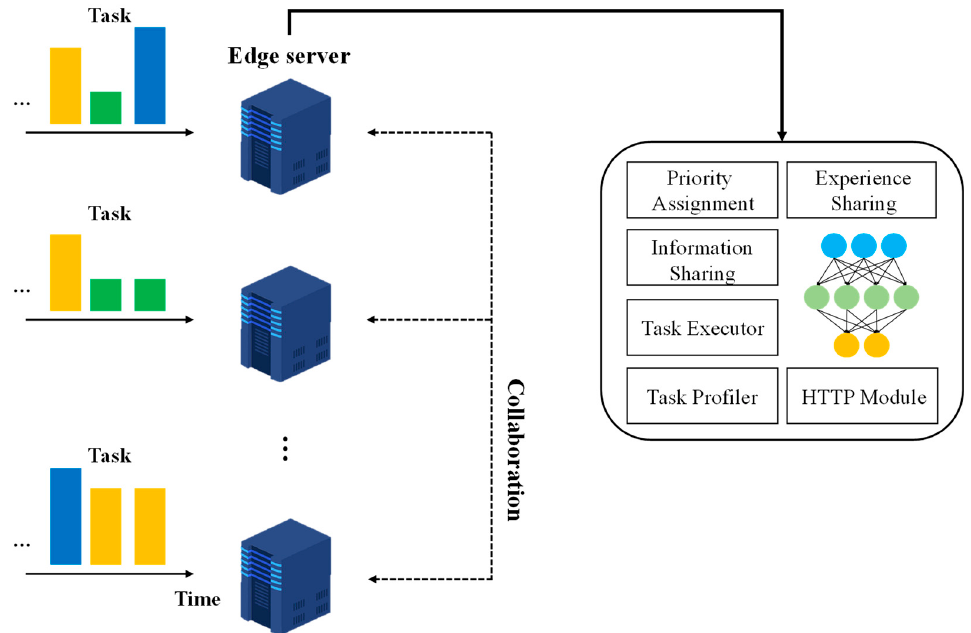
Figure 1. The structure of the proposed scheme.